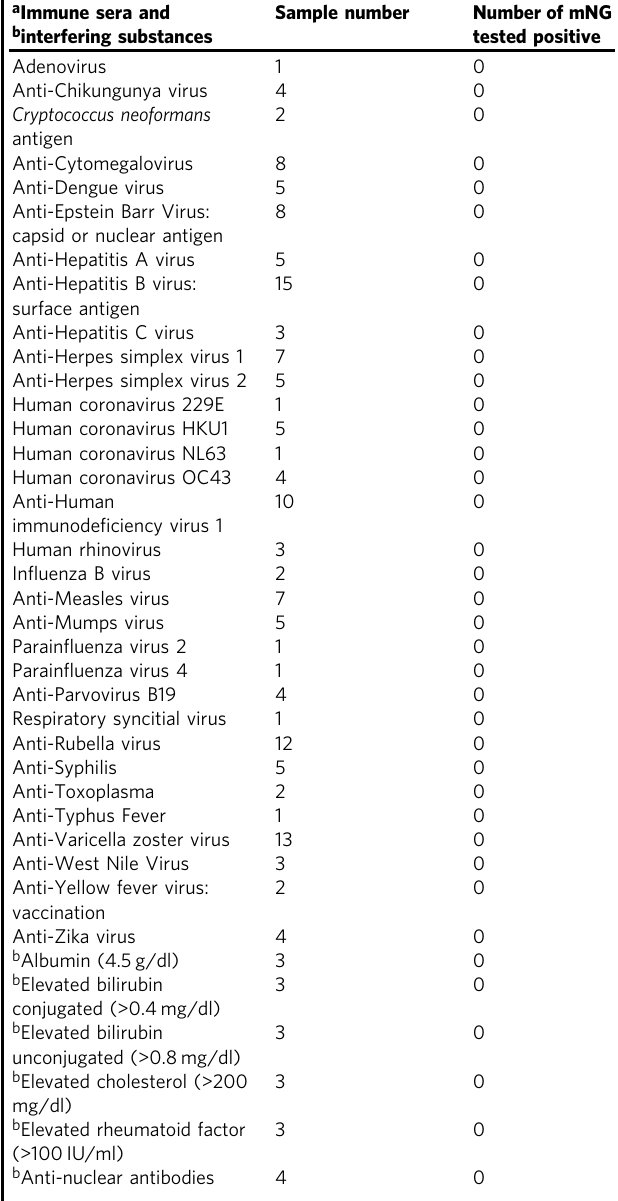
alphabetical order. Samples tested positive for antibodies against speci fi c pathogens are indicated with pre fi x “ anti ” , whereas samples tested positive on antigens or pathogen nucleic acids are notindicated with pre fi x. For the latter group, the specimens werecollected within1 to 6 months after the antigen or PCR tested positive. b A total of 19 samples tested for interfering substances and autoimmune disease nuclear